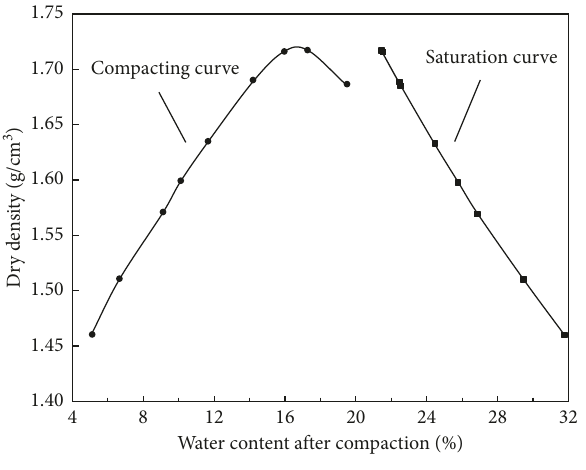
Figure 2: Compaction curve.